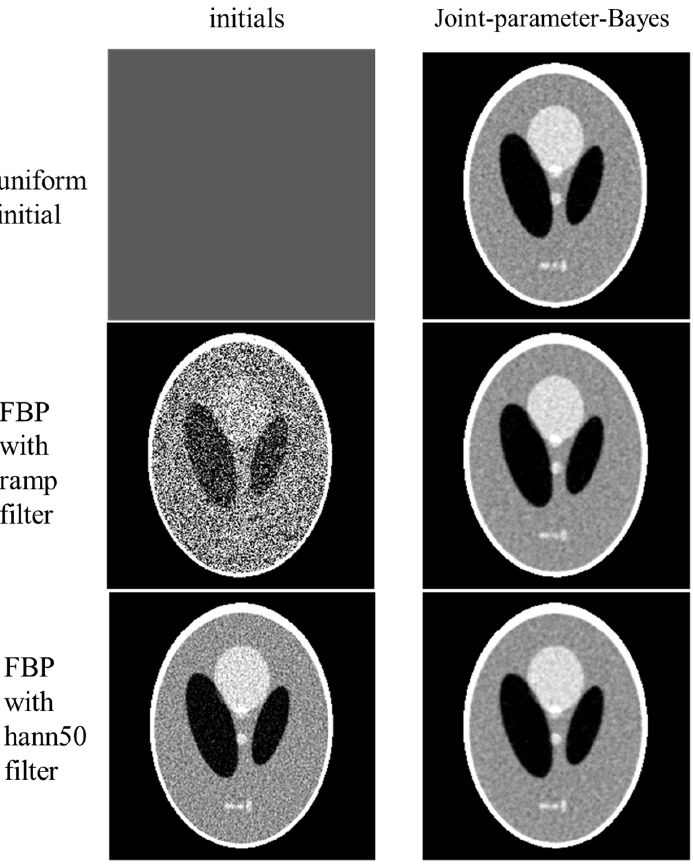
Figure 6. Performance of joint-parameter-Bayes with different initials. From top to bottom, the initials ( left column ) are uniform averaged from FBP, FBP with ramp filter, and FBP with hann50 filter, while the corresponding joint-parameter-Bayes reconstructions are shown on the right ( right column ).